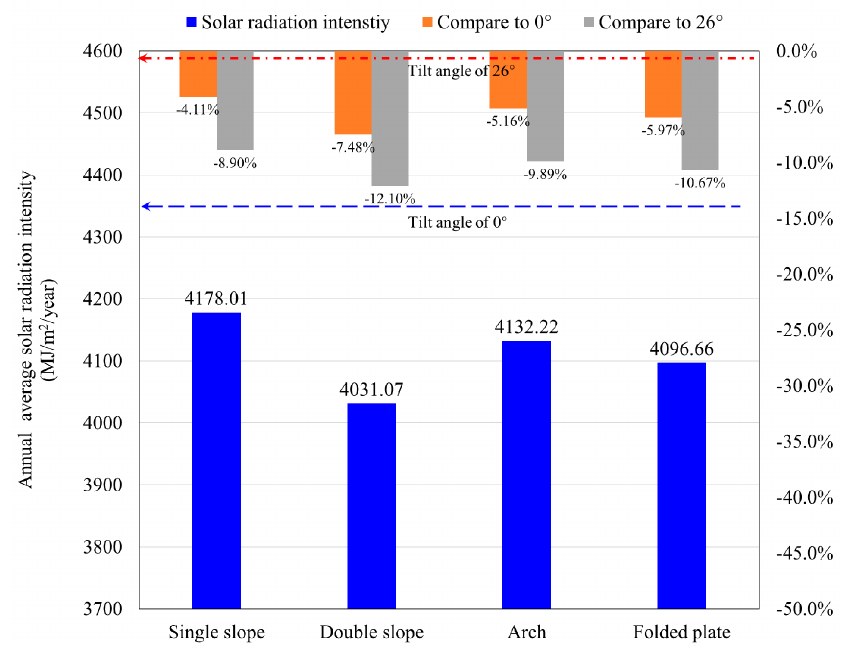
Figure 14. Annual average solar radiation intensity of rectangular gymnasium buildings with the four roof shapes.